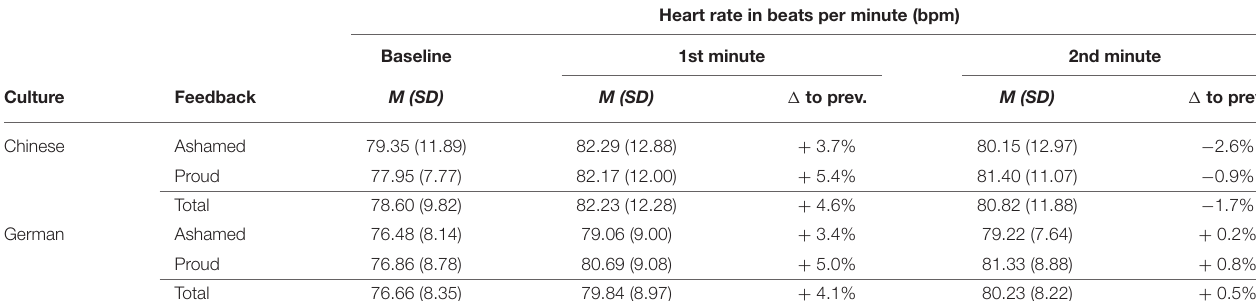
TABLE 2 | Descriptive statistics for heart rates and relative heart rate changes between the three measuring